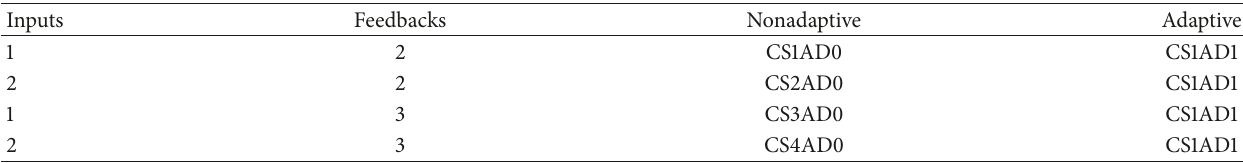
Table 4: Experimental configurations.